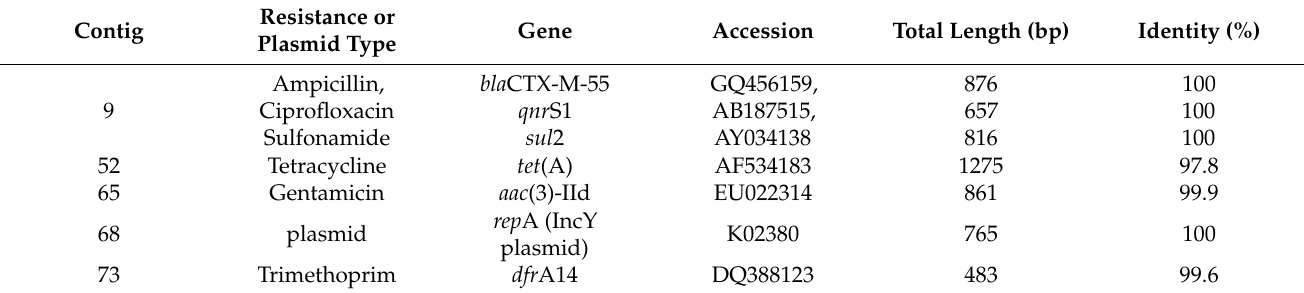
Table 3. DNA contigs with antibiotic resistance or plasmid backbone genes assembled by whole genome sequencing of E. coli strain